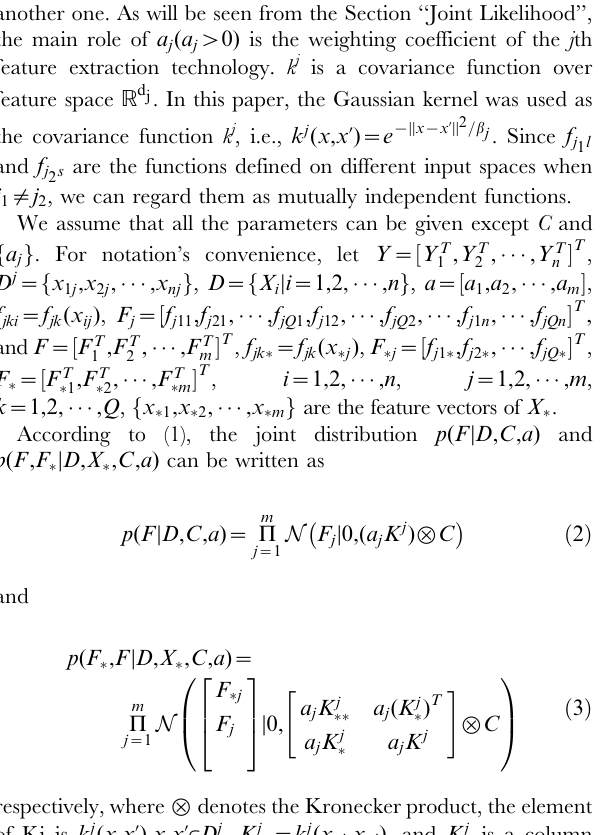
algorithm imbalanced multi-modal multi-label Gaussian